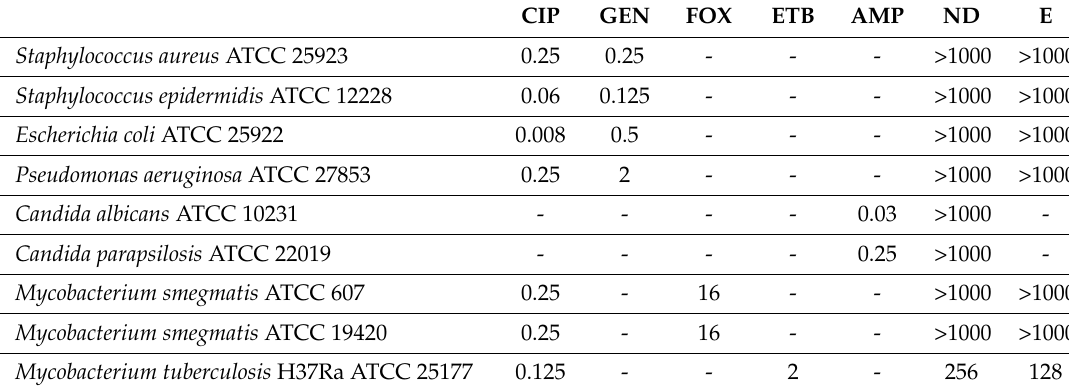
Table 4. The antimicrobial activity of tested samples. The activity was expressed as minimal inhibitory concentration ( µ